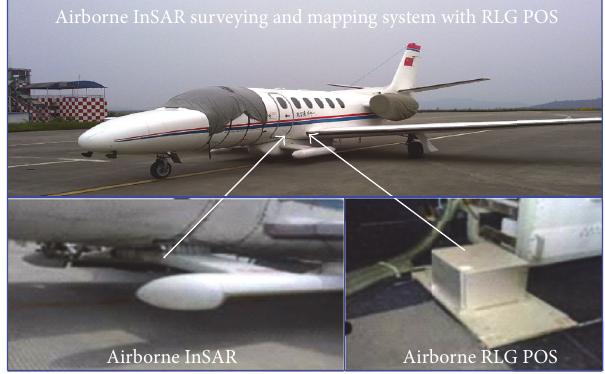
Airborne InSAR surveying and mapping system with RLG POS